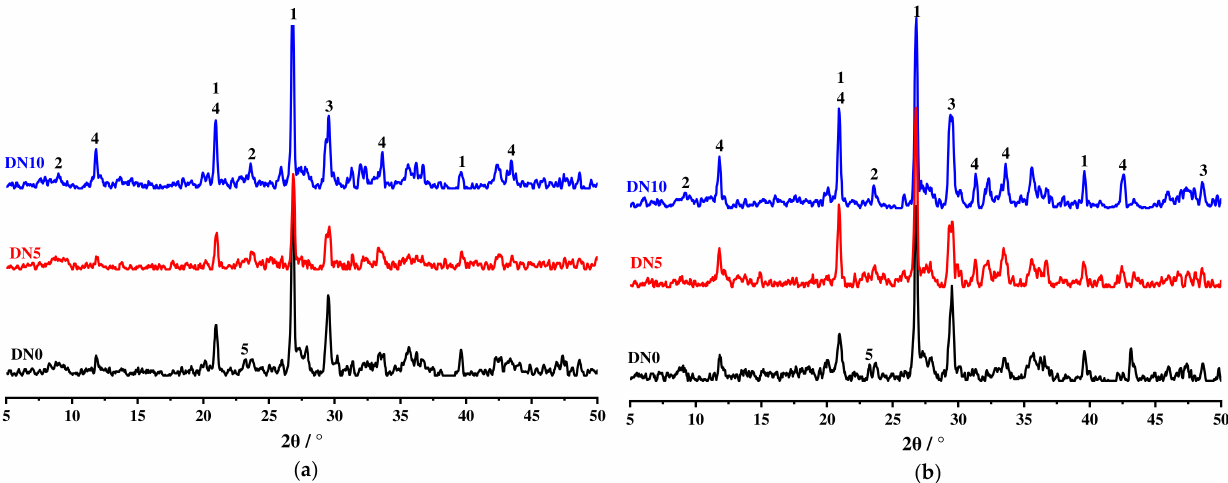
Figure 10. XRD diagrams for the erosion products: ( a ) XRD for erosion products from different solutions after the 8th cycle; ( b ) XRD for erosion products from different solutions after the 12th cycle. (1: quartz (SiO 2 ); 2: ettringite (AFt); 3: calcite (CaCO 3 ); 4: gypsum (CaSO 4 · 2H 2 O); 5: calcium hydroxide (Ca(OH) 2